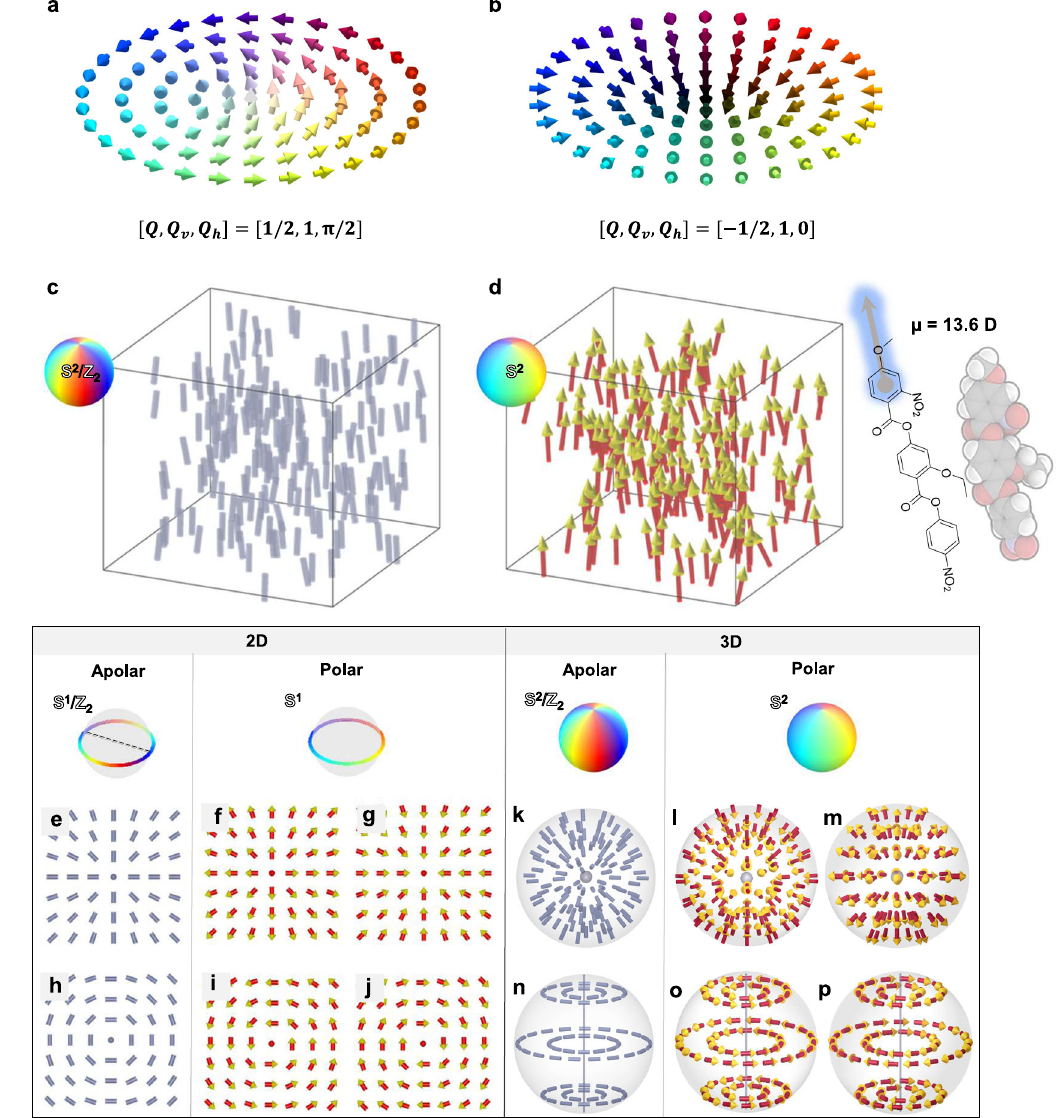
Fig. 1 | Topological analogy between nonpolar and polar systems. a , b Illustrations of 2D merons with different sets of topological charge, vorticity number and helicity number, i.e., [ Q , Q v , Q h ]. a Bloch-type meron with Q , Q c Head-to-tail-equivalent director fi eld of nonpolar nematics. d Head-to-tail- inequivalent polarization fi eld of ferroelectric nematics. The polarization entity o f RM-OC 2 isshown. e A+1hedgehog-typedefectin2Dnonpolarnematics. f , g The